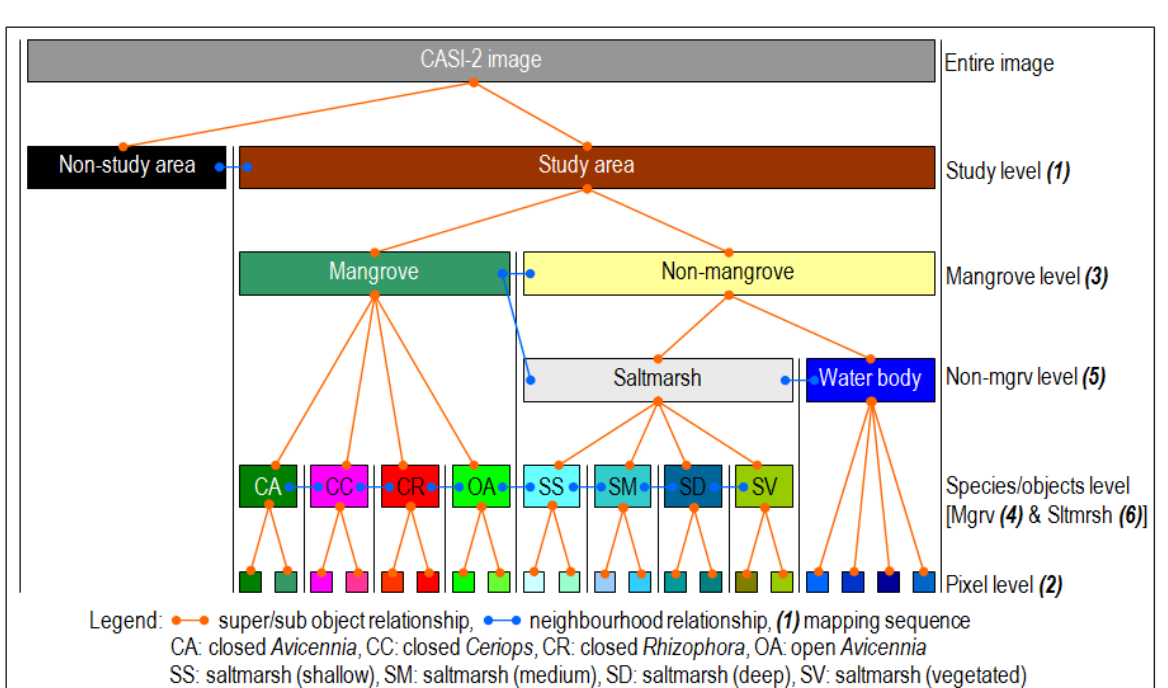
Figure 10. Image object hierarchy and the mapping